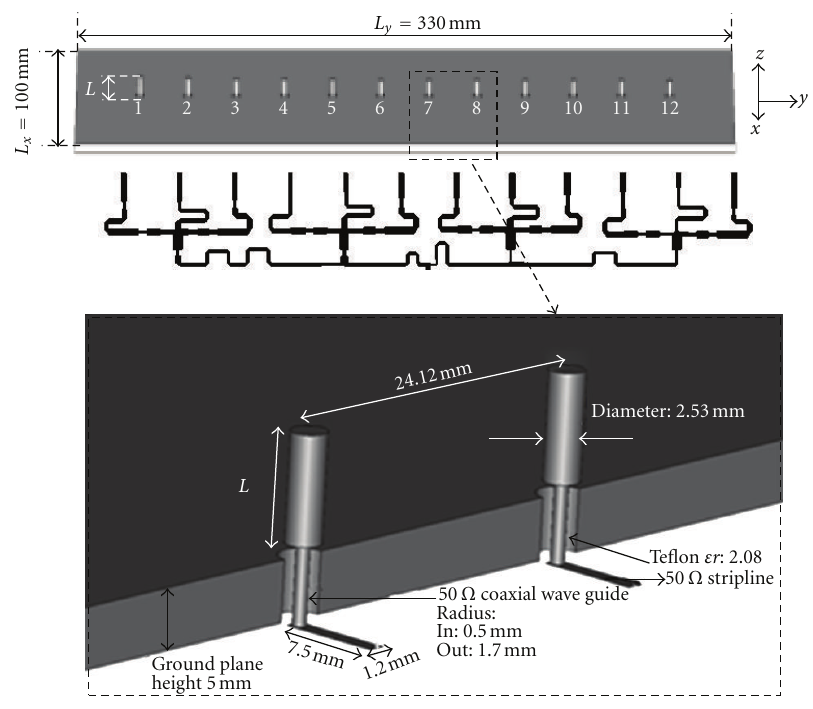
Figure 5: Array of 12 monopoles with its feed distribution